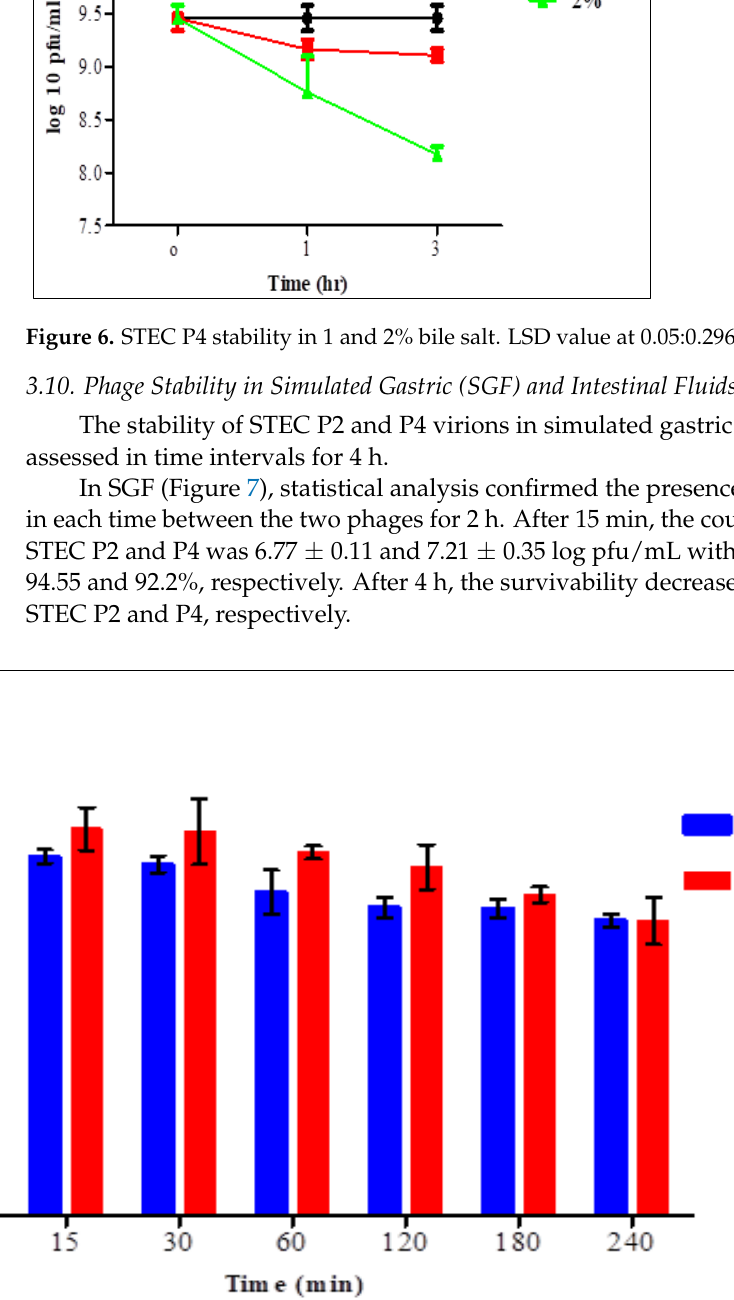
Figure 5. STEC P2 stability in 1 and 2% bile salt. LSD value at 0.05:0.296.